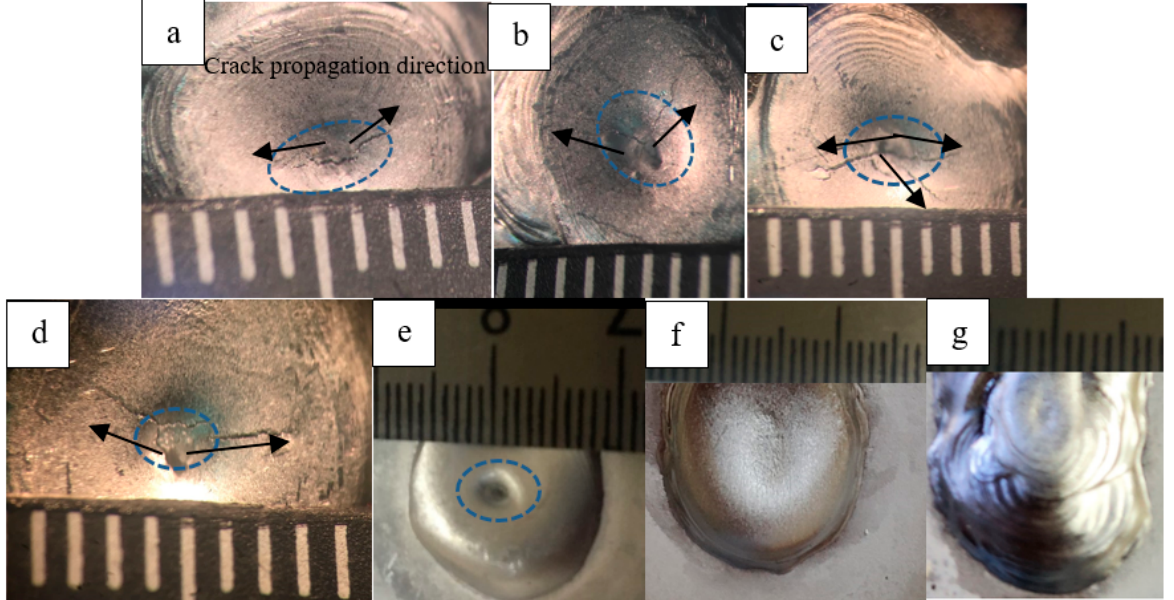
Figure 4. Effect of wire feeding speed on the solidification cracking of the aluminum alloy: ( a ) 4 m/min; ( b ) 4.5 m/min; ( c ) 5 m/min; ( d ) 5.5 m/min; ( e ) 6 m/min; ( f ) 6.5 m/min; ( g ) 7.0 m/min.